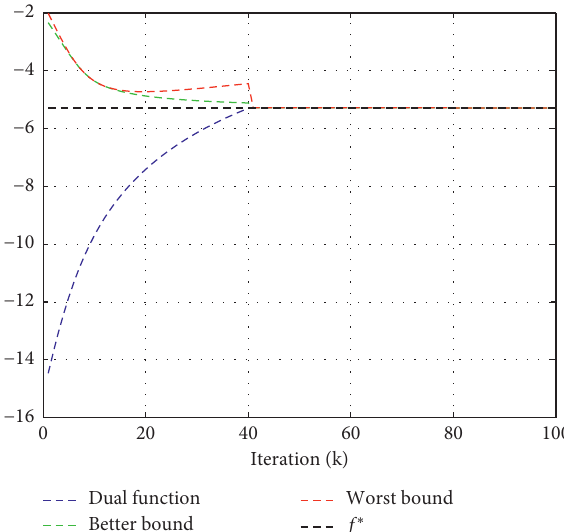
Figure 10: Convergence of the dual function iterates g ( λ k ) , the better bound and the worst bound. The figure shows clearly that g ( λ ) is being a lower bound on f ∗ and the better bound gives a more better approximation on f ∗ than that of the worst bound. However, all 3 bounds converge to the optimal value f ∗ of the original problem (41) for sufficiently large k